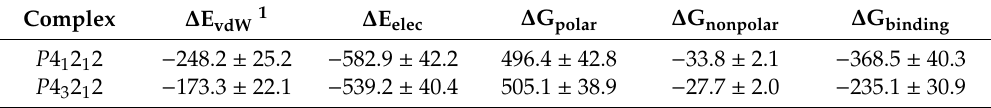
Figure 4. Molecular dynamics (MD) analysis of the two Arg peptide-binding modes. ( A ) Ensembles of Arg peptide conformation obtained from the last 25-ns MD simulation. The bound Arg peptide in every snapshot is shown as a C α trace and colored in the rainbow scheme. ( B ) The root-mean-square fluctuation (RMSF) of the C α atoms in the bound Arg peptide calculated from the results shown in (A). ( C ) Ensembles of Arg-binding poses during the last 25-ns MD simulation. The carbon atoms of the bound Arg (R62*) are shown in green, and those of the binding residues are in gray. The oxygen and nitrogen atoms are colored in red and blue, respectively. Potential hydrogen bonds or salt bridges are depicted as black dotted lines. ( D ) The RMSF of the residues in the R62*-binding site calculated from the results shown in (C). ( E ) The timeline of hydrogen bonds formed in the binding site during the 50-ns MD simulation. The hydrogen bonds formed between R62* and the binding residues are depicted in grayscale lines; the grayscale represents the hydrogen bond distance, which indicates the bond strength. Table 4. Predicted binding free energies of XopAI-peptide